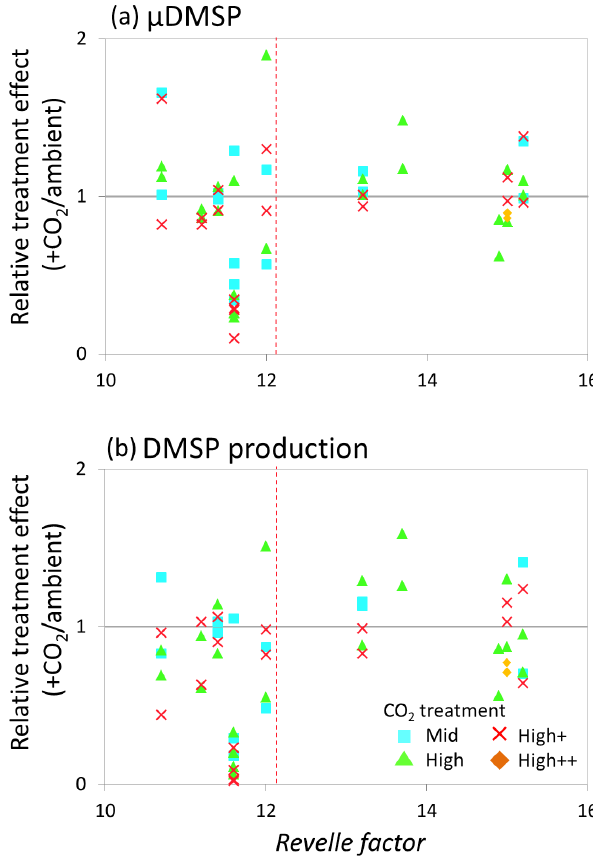
Figure 8. Relationship between the Revelle factor of the sampled water and the relative CO 2 treatment effect at ( [ x ] highCO / [ x ] ambientCO ) for (a) de novo DMSP synthesis 2 2 ( µ DMSp, d − 1 ) at both time points 1 and 2 and (b) DMSP pro- duction rate (nmolL − 1 d − 1 ) at both time points 1 and 2 for mi- crocosm experiments performed in north-western European waters, sub-Arctic and Arctic waters, and the Southern Ocean. Grey solid line ( = 1) indicates no effect of elevated CO 2 . Revelle factor > 12: polar waters (indicated by red dashed line). Time point 1 = 48h and time point 2 = 96h, except for Weddell Sea and South Georgia (1 = 72h, 2 = 144h). For discussion of the north-western European shelf data, see Hopkins and Archer